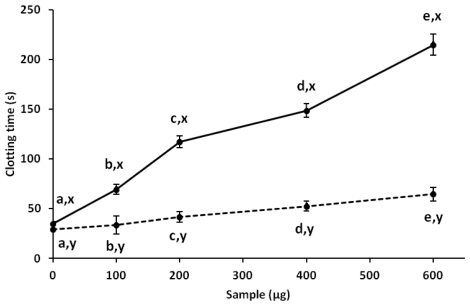
Clotting time using the aPTT test affected by corn cob xylan after carboxy-reduction reaction. Continuous line represents the original xylan and the dashed line represents the xylan after decarboxylation. a,b,c,d,e Different letters indicate significant differences between different concentrations used; x,y Different letters represent significant difference between similar concentrations in the different samples used. 1 μg of heparin > 240 s. Student-Newman-Keuls test (p < 0.05).